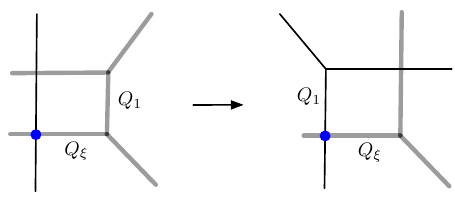
Figure 17 . These brane webs describe the theory U(1) 0 + 2 F with k eff = 0 + 2 / 2 = 1 . We move the massive D5-brane to get the symmetric brane web.